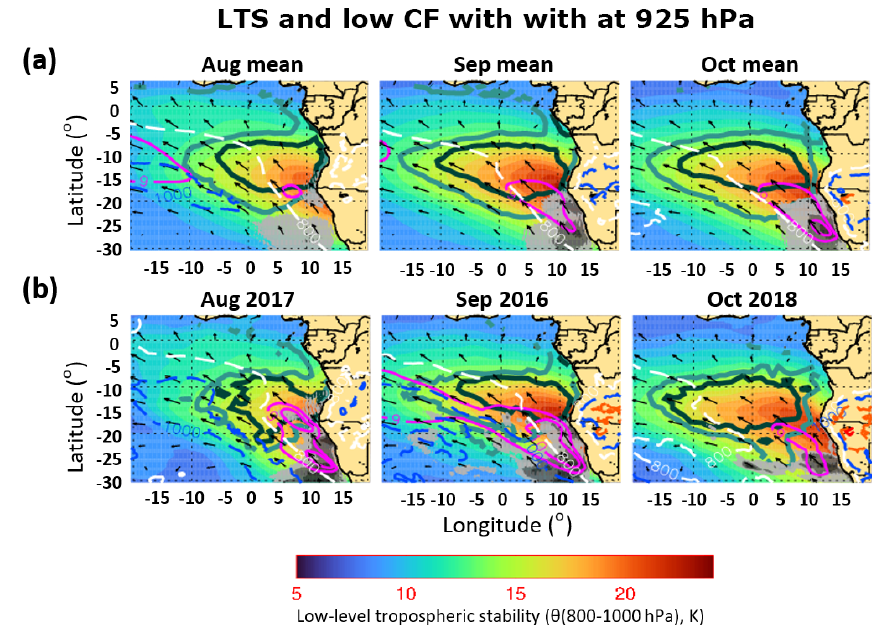
Figure 7. Maps of LTS (shading; color; Kelvin) and low-level cloud fraction (low CF; cloud-top height below 2.5km; 0.8 (light green) and 0.9 (dark green); percent) overlain by subsidence (omega at 800hPa; 50, 65, and 80hPad − 1 ; increasing from light gray to dark gray), BLH (dashed contours in white, blue, orange, and red from 800 to 1400 in 200m increments; meters), and 925hPa horizontal wind speed (magenta contour; ms − 1 ). The 925hPa wind vector (arrow) for panel (a) , the climatological mean (2003–2018 for low CF and 2000–2018 for other variables), and (b) the deployment